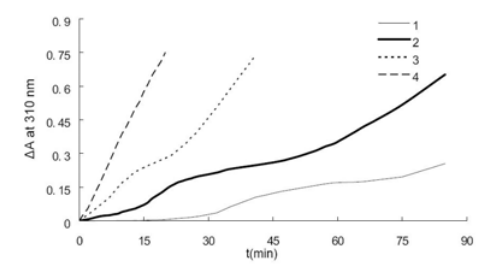
Fig. 9 Kinetic curves of the LiP catalyzed oxidation of VA at several PR concentrations. Conditions: The LiP (0.2 μ M) catalyzed oxidation of VA (10 mM) in the presence of PR ([PR] = 55 (1), 40 (2), 20 (3), 0 (4) μ M) was initiated by H 2 O 2 supplied enzymatically ([GOD] = 0.3 μ g · mL − 1 , [glucose] = 0.1 mM) and monitored spectrophotometrically at 310